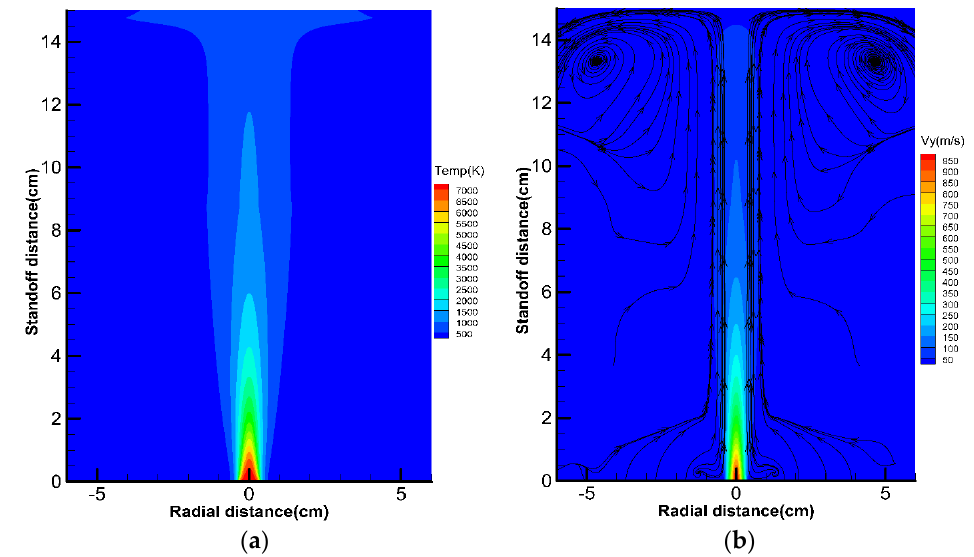
Figure 4. Gas temperature contour ( a ), and axial velocity contour with streamlines ( b ).